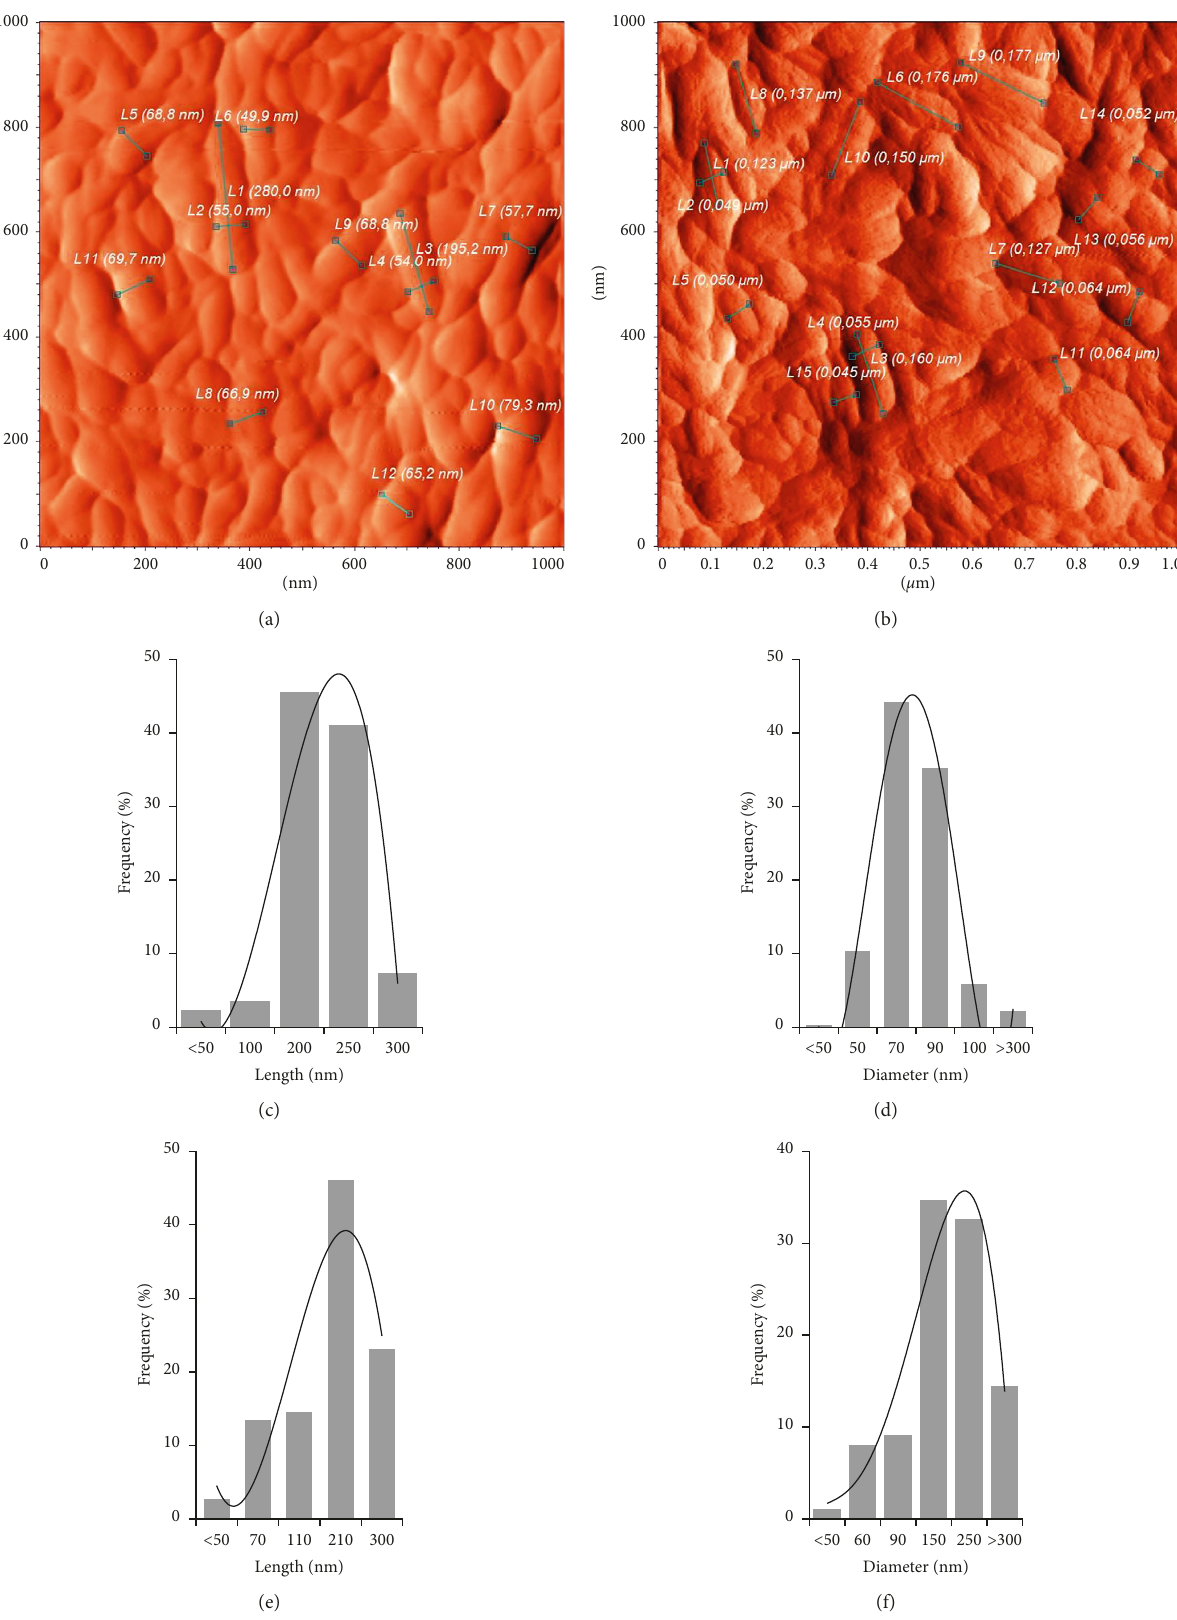
Figure 2: AFM images (a, b) and histograms of length (c, e) and diameter (d, f) distributions of ChN-X (a, c, and d) and ChN-K (b, e, and